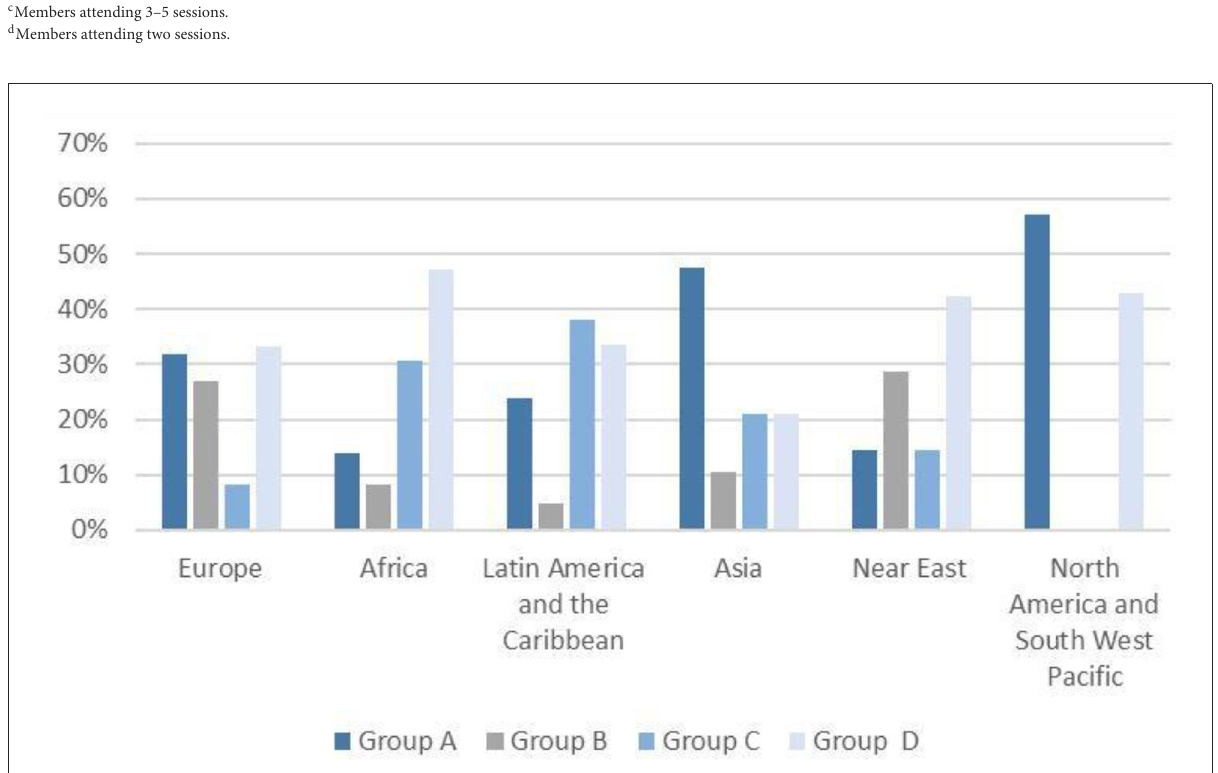
FIGURE1 Percentage of participants attending CCNFSDU a sessions by region, 2009–2019. a The Codex Committee on Nutrition and Foods for Special Dietary Uses.